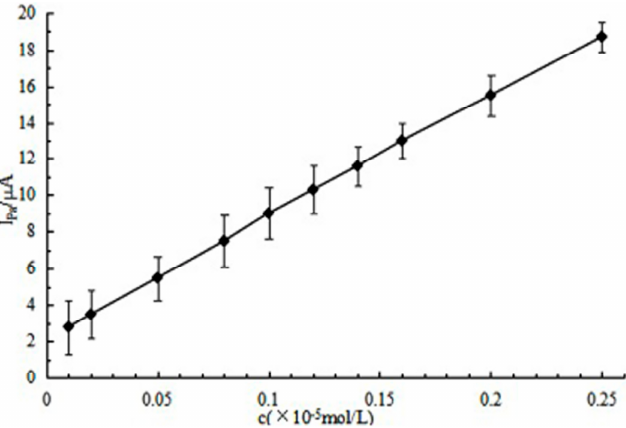
Figure 9. The peak current of CGA at different concentration.